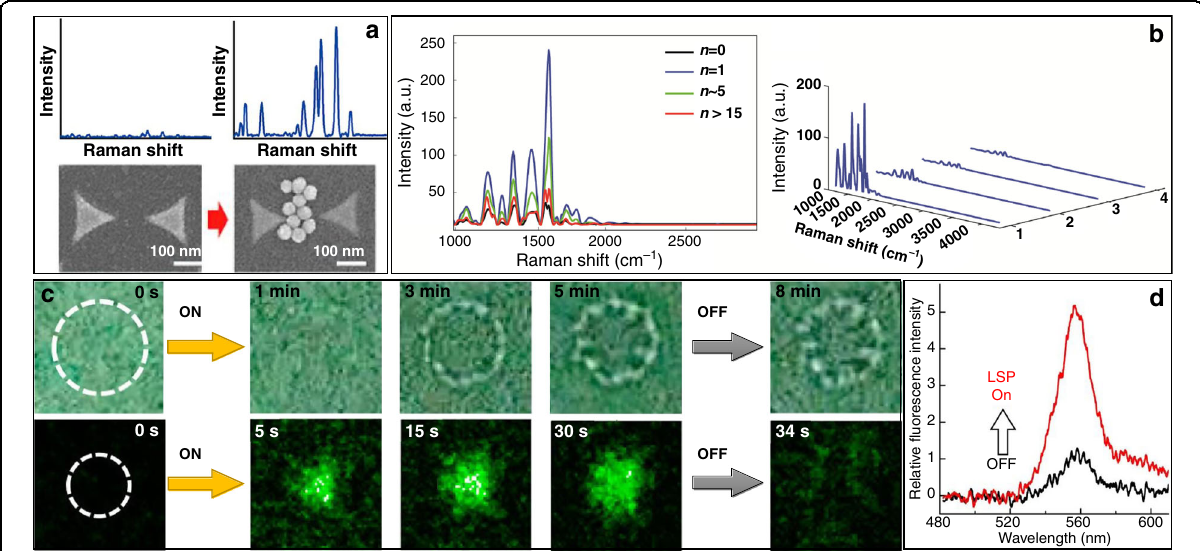
Fig. 15 Enhanced spectroscopy in plasmonic tweezers. a Enhanced Raman spectroscopy via plasmonic trapping of gold nanoparticles in the middle of initially fabricated nanobowtie structures. b Experimentally measured SERS spectra in the SPP tweezer system, which shows the in fl uence of the trapping number. c Permanent fi xing or reversible trapping and release of DNA micropatterns. Top: bright- fi eld micrographs; bottom: fl uorescence micrographs. Laser illumination covered the white dotted circle. d Fluorescence spectrum of dye aggregates with (red) and without (black) LSP excitation. a Reproduced with permission from ref. 295 , Copyright 2016 American Chemical Society. b Reproduced with permission from ref. 163 , Copyright 2017 The Royal Society of Chemistry. c Reproduced with permission from ref. 215 , Copyright 2013 American Chemical Society. d Reproduced with permission from ref. 298 , Copyright 2017 Optical Society of